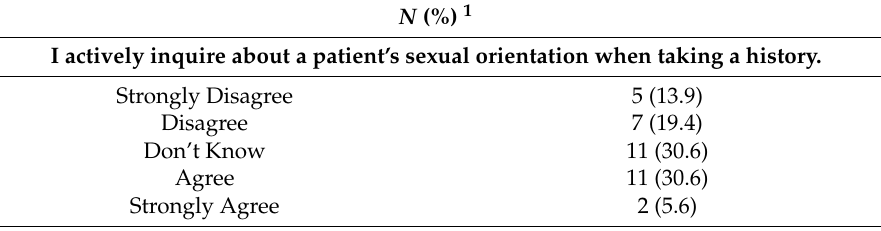
Table 4. LGBTQ-related practice behaviors among indicated providers ( N = 36). N (%)